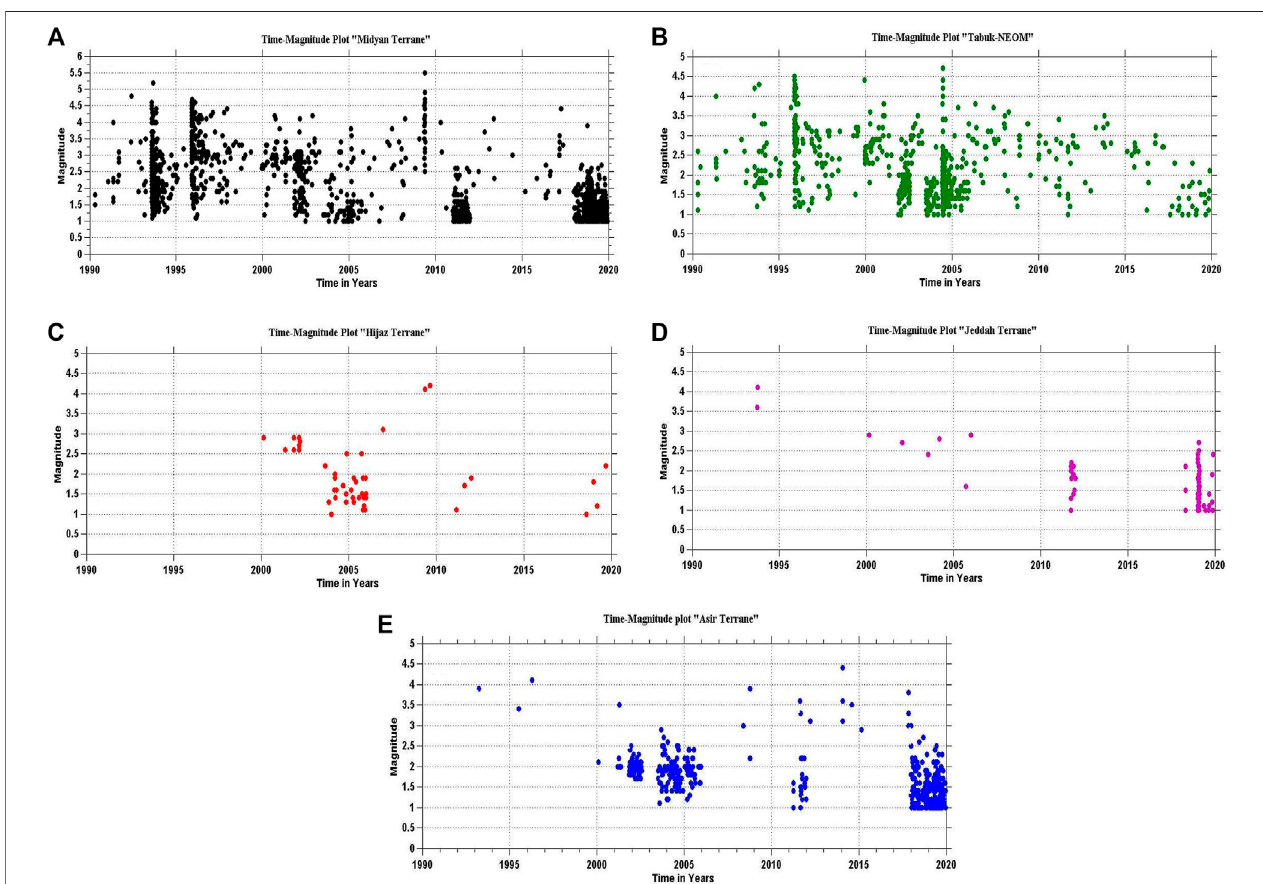
FIGURE 12 | (A – E) Time – magnitude distributions for the studied regions as represented by the color legend.